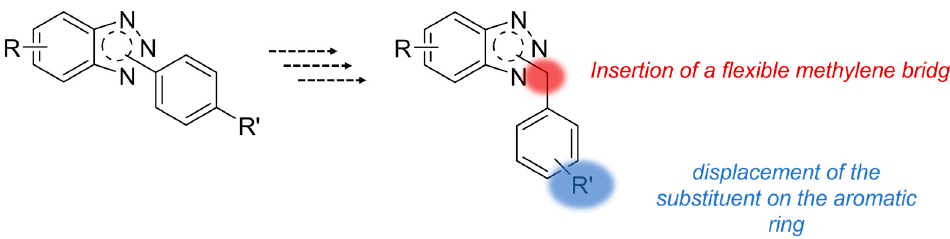
Figure 4. Structural modifications on our hit compounds: introduction of a methylene bridge (red) and displacement of the substituent on the benzene ring (blue).